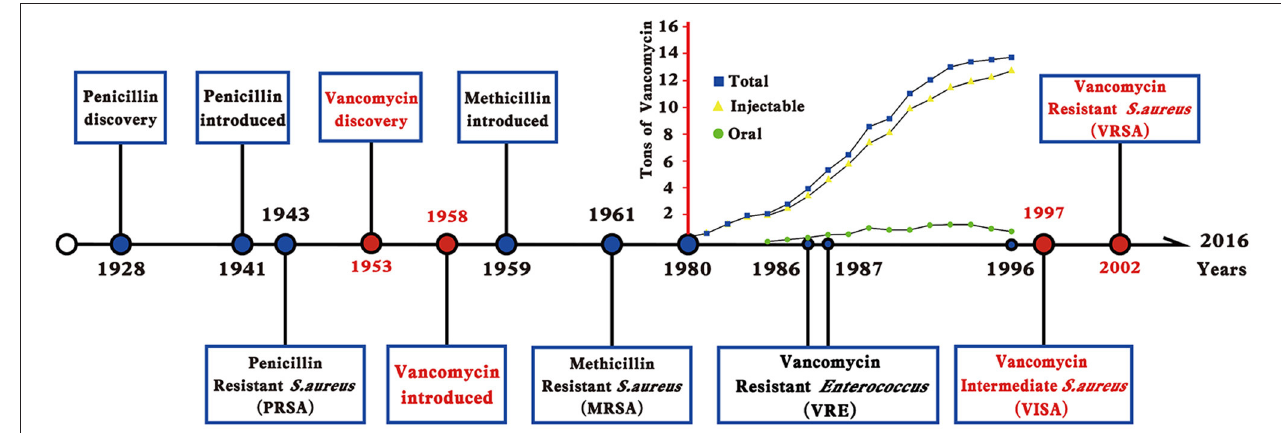
FIGURE 2 | Timeline indicates the year in which an event occurred or was reported. The increased use of vancomycin in the USA, France, Italy, Germany, the United Kingdom, and the Netherlands was shown as tons of vancomycin in the y-axis, which was modified from reference Levine (2006).